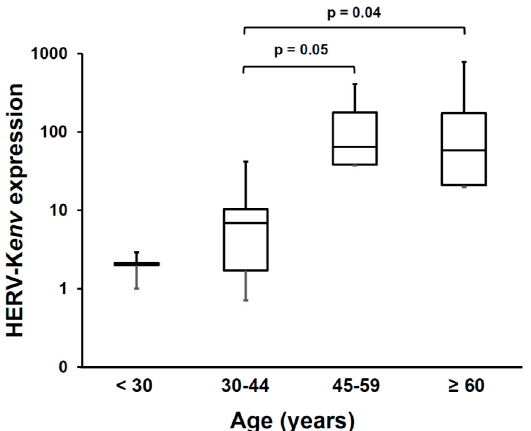
Figure 4. Age-related levels of HERV-K(HML-2) env polyA + RNA in plasma from healthy volunteers. Published methods were used for blood fractionation and mRNA extraction [27,44], and for HERV-K(HML-2) env retro-transcription and real time amplifications [55]. The data were calculated by the 2 -Ct method, and are expressed in arbitrary units. The absence of cellular contaminants was assured by evaluation of glyceraldehyde-3-phosphate dehydrogenase housekeeping gene transcripts, before and after the reverse transcription step.